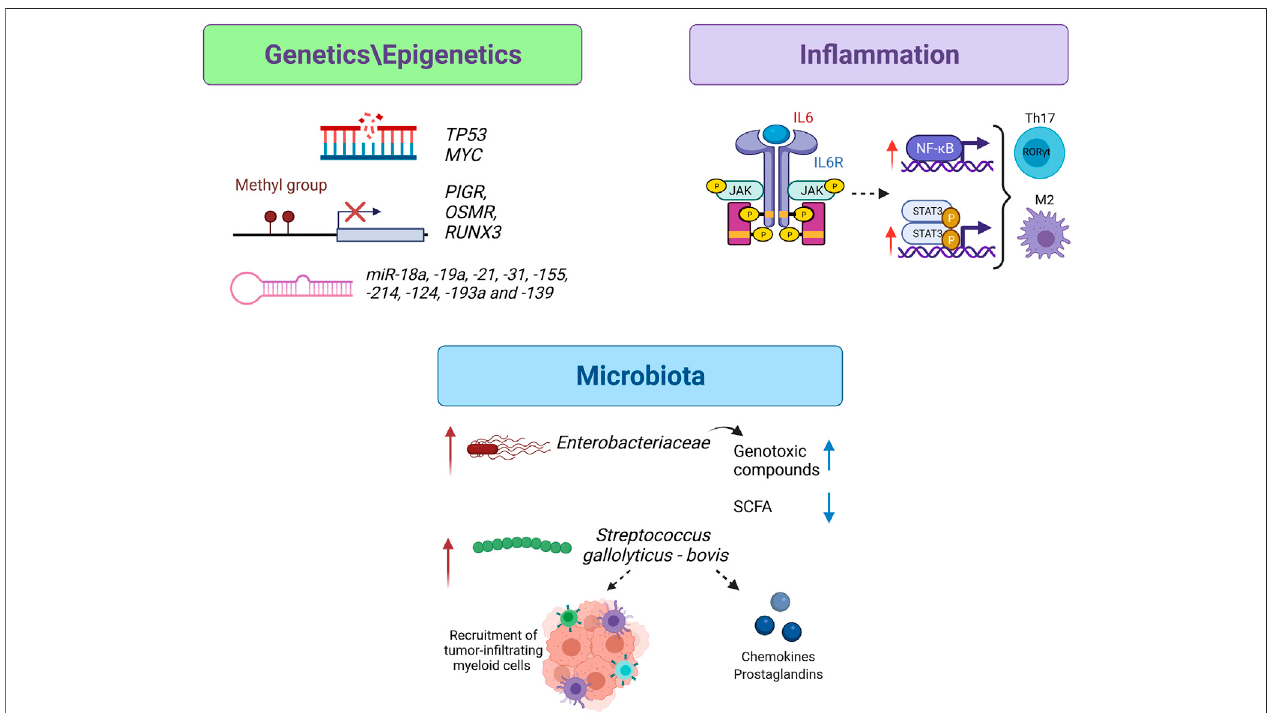
FIGURE 1 | From IBD to CRC: possible key players in carcinogenesis within intestinal mucosa. Intestinal epithelial cells of IBD-CRC patients present a different frequency of somatic mutations, altered DNA methylation sites and deregulated microRNA in comparison to sCRC. The anti-apoptotic role of NF- κ B in cancer cells enhancedtheirproliferation,promotingtumorprogression.Moreover,anexacerbatedactivationofNF- κ B`andSTAT3signaling, via IL6,drivesM2polarizationandTh17 differentiation favouring IBD-CRC carcinogenesis. Enterobacteriaceae strains are responsible for the production of genotoxic compounds and for the reduction of intestinal levels of anti-in fl ammatory SCFA; Streptococcus genus could exert its tumorigenic activity through the recruitment of tumor-in fi ltrating myeloid cells ( S. gallolyticus ) and the release of chemokines and prostaglandins ( S. bovis ). The image was created with